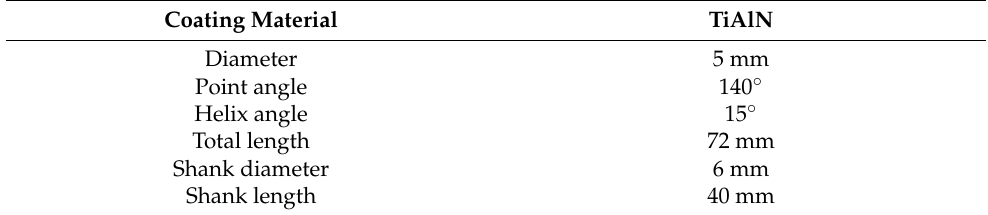
Table 1. Specifications of drill bit used in the experiments. (DH500050, YG1 Co., Ltd.).